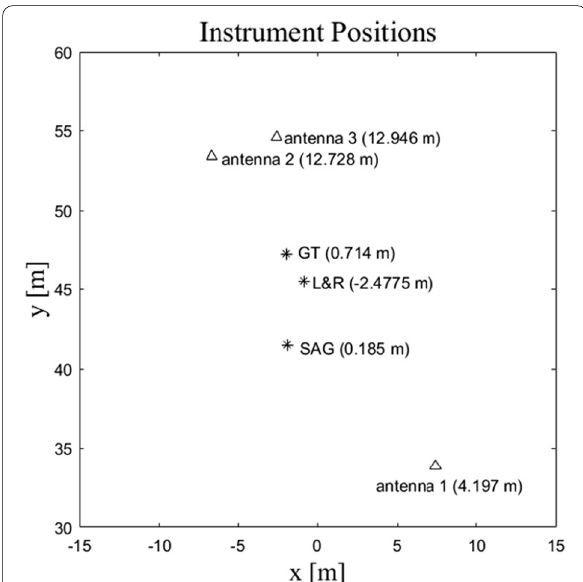
Fig. 2 Positions of the GNSS antennas and gravimeters in the body coordinate system that the origin of coordinates is set on the deck and the y-axis points to the bow and the x-axis points to starboard. A total station was set up at the origin of coordinates to measure the coordinate center of each instrument. The numbers in parentheses represent the elevation, triangles represent GNSS antennas, and stars represent